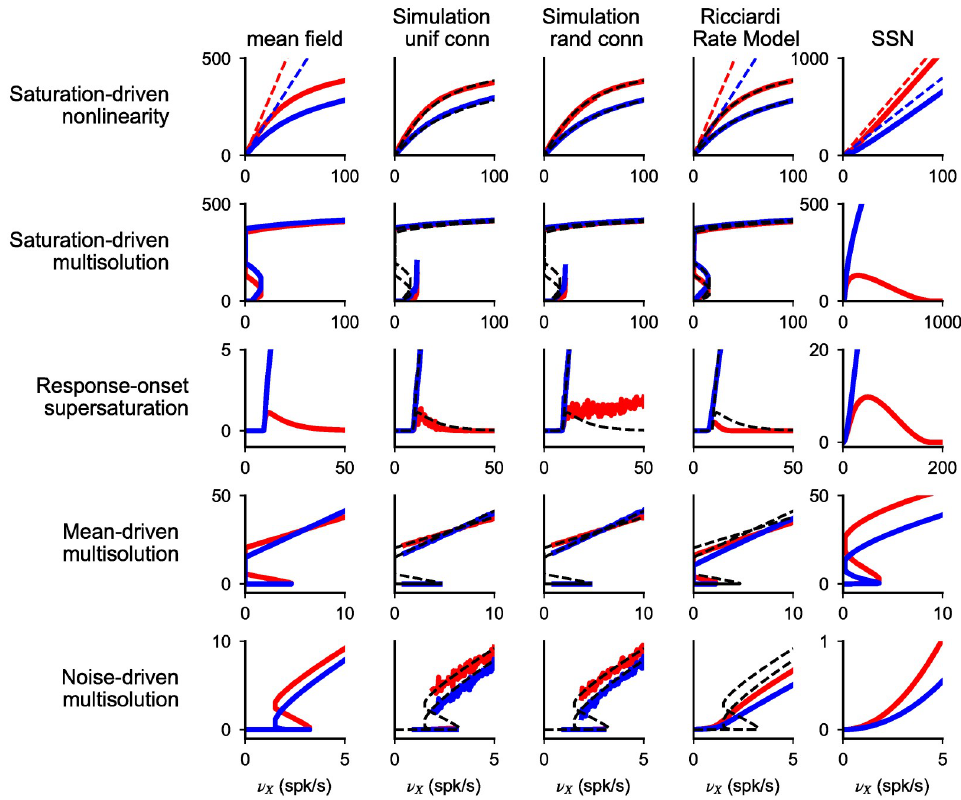
Fig 8. Spiking-networks nonlinearities in network simulations and rate models. Comparison of responses of excitatory (red) and inhibitory (blue) neurons computed with: mean field theory of spiking networks (colored lines in first column and black dashed lines in second to fourth columns); network simulation with uniform (second column) and random (third column) connectivity; rate models (Ricciardi model, fourth column, and the SSN, fifth column). Different rows correspond to different values of α and g . Prediction of the mean field theory match numerical E , I E , I simulations, with the only exception of the lack of supersaturation in networks with random connectivity. Spiking networks present nonlinearities at saturation and at response-onset. Saturation nonlinearities are generated by the refractory period and hence are captured only by the Ricciardi model and not by the SSN, which lack this ingredient. These nonlinearities have effects also at low rate and constrain the parameter space over which the response is unique. Response-onset nonlinearities have similar structure in the three models but in spiking networks are smaller in size and feature multiple solutions generated by noise feedback. Network structure (from top): g E = 8, g I = 7, α E = 4, α I = 2; g E = 2.08, g = 1.67, α = α = 1; g = 4.5, g = 2.9, α = α = 1; g = 4.1, g = 2.46, α = 1, α = 0.2; g = 7, g = 6, α = 1, α = 0.7. I E I E I E I E I E I E I E I In all simulations, for spiking-networks mean field, simulations and Ricciardi model: J EE = J IE = J ; K EX = K EE = K IE = K ; g EX = g IX = 1. (except second row, where J EE = J IE 2.5/2.4 = J , and fourth row, where K EX = K EE = 2 K IE = 2 K ); values are 400 for K and 0.2mV for J in all simulations except for noise driven bistability where J = 0.5mV. In Ricciardi model, σ = E σ I = σ ; σ matches noise at threshold in spiking neurons and is (from the top): 25mV, 10mV, 3mV, 5mV, 7mV. In the SSN, k = 0.04, n = 2, W = W = 1, W = γ g except in second row, where W = 2.4/2.5 and W = γ g 2.4/2.5, and EE IE AI A IE EI I fourth row where W EE = 2 and W EI = 2 γ g E